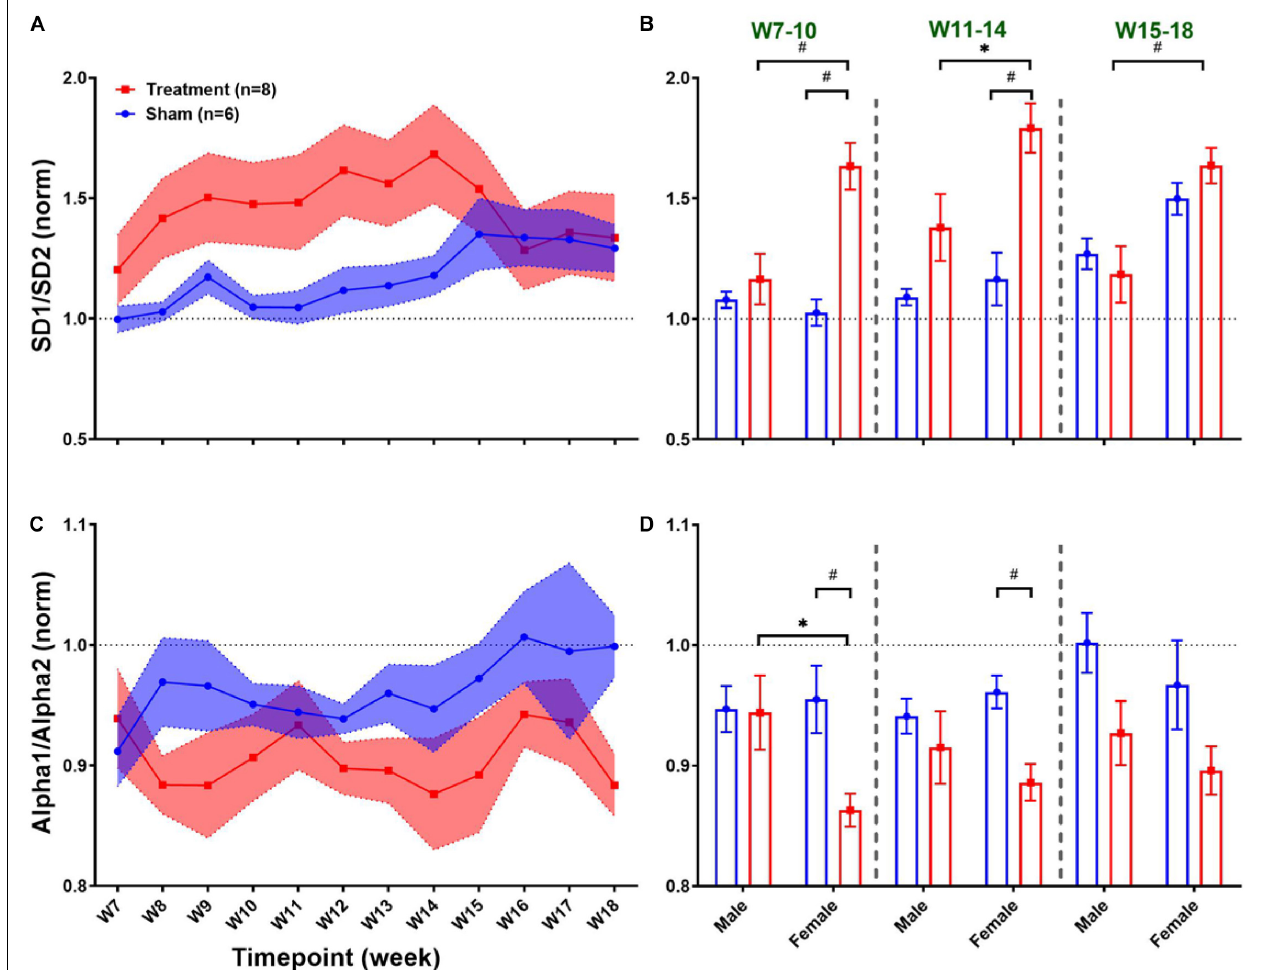
FIGURE 8 | Normalized long-term trends for HRV non-linear features (mean ± SEM). (A,B) The long-term effect of VNS on SD1/SD2 is not significantly different between Treatment and Sham groups; however, an increasing trend during VNS is obvious in the Treatment group. VNS effects on SD1/SD2 seem to be similar in male and female rats, but a significant effect was only observed in the female group for early VNS and late VNS phases. (C,D) While VNS slightly decreases Alpha1/Alpha2, there is no significant difference between Treatment and Sham groups in the long-term effect. However, when male and female rats were compared from each group, this reduction appears to be significant only in female rats during VNS_Early and VNS_Late phases. * p < 0.05 and # p < 0.01.